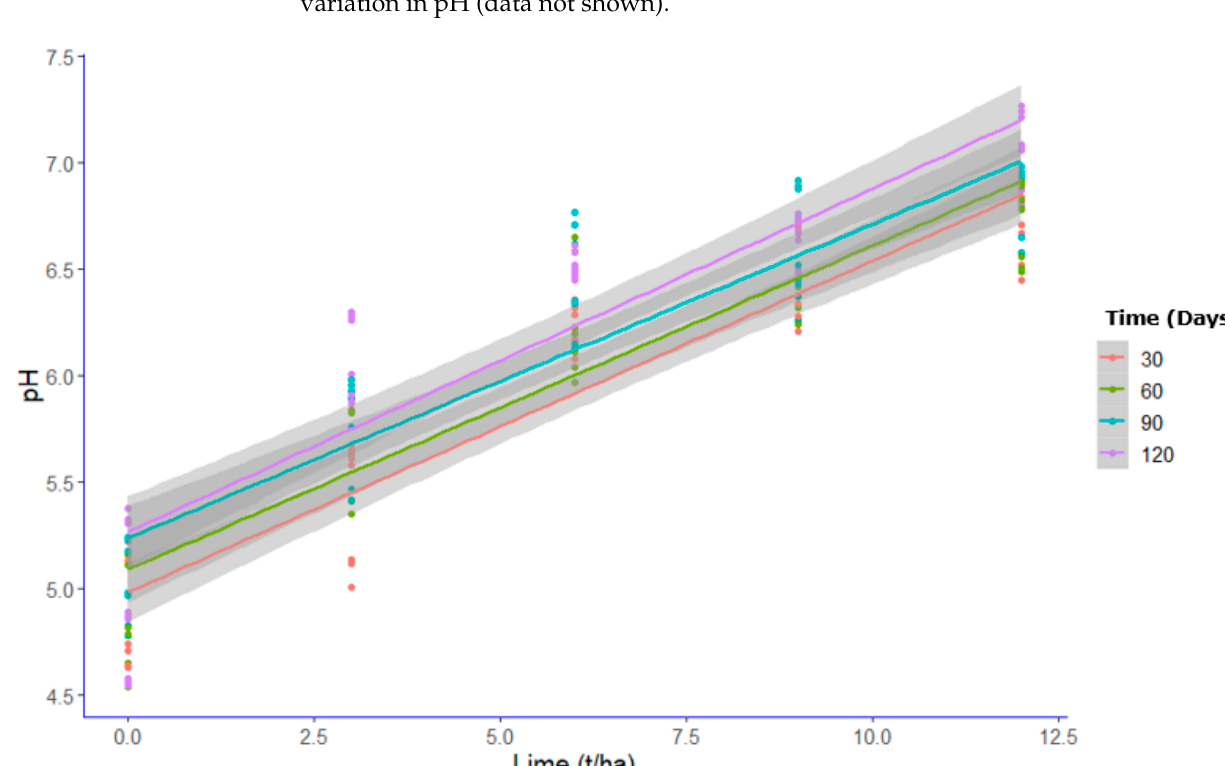
Figure 3. Correlation between soil acidity and bacterial wilt incidence in different potato fields. Each point indicates an observation of soil pH and bacterial wilt incidence from a different potato field.